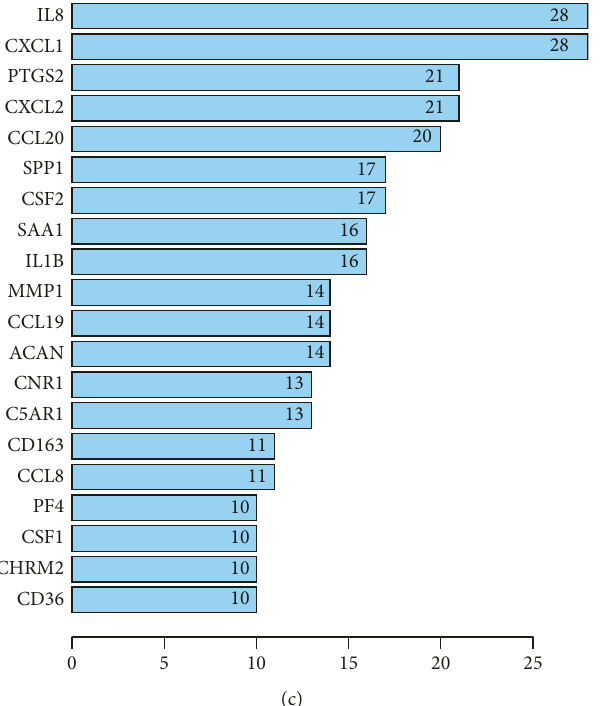
Figure 4: PPI network analysis of the most signi fi cant changed genes was constructed. A total of 3 subnetworks and 20 central nodes were identi fi ed by Cytoscape MCODE plugin.